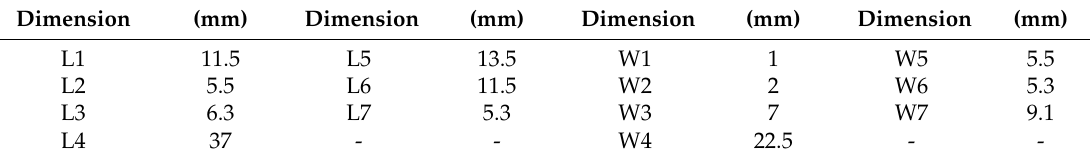
comparison of the simulated results for types 1, 2, and 3. ( d )